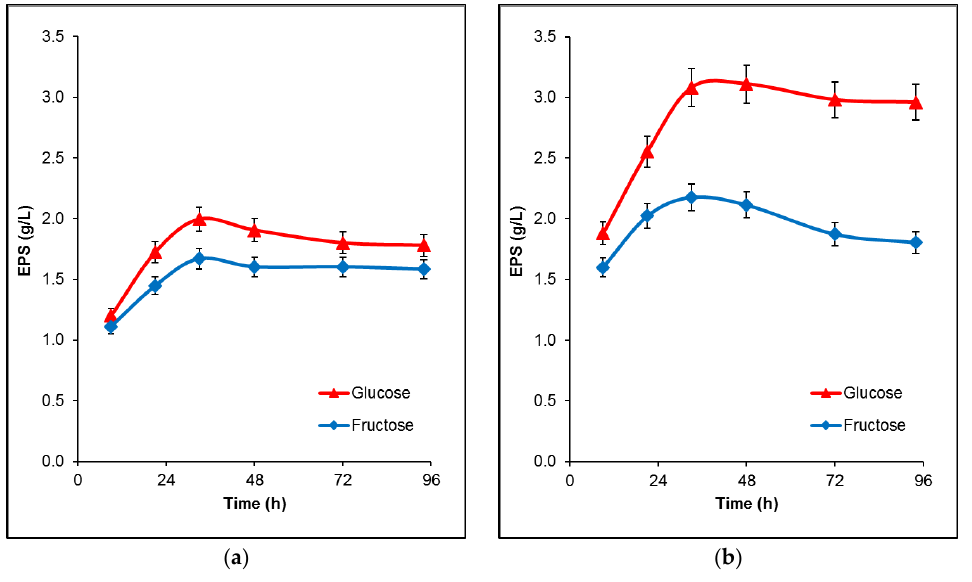
Figure 2. Time profiles of EPS production by B. licheniformis 24 during fermentation in flasks. ( a ) EPS production from glucose or fructose with initial concentration 50 g/L; ( b ) EPS production from glucose or fructose with initial concentration 100 g/L. The mean values from three independent cultivations are presented.